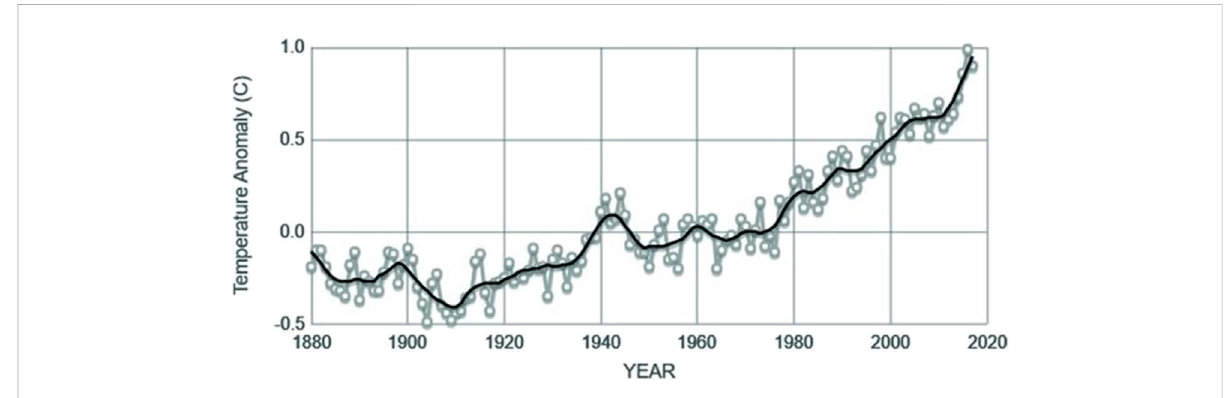
FIGURE 4 Global land – ocean temperature (NASA,